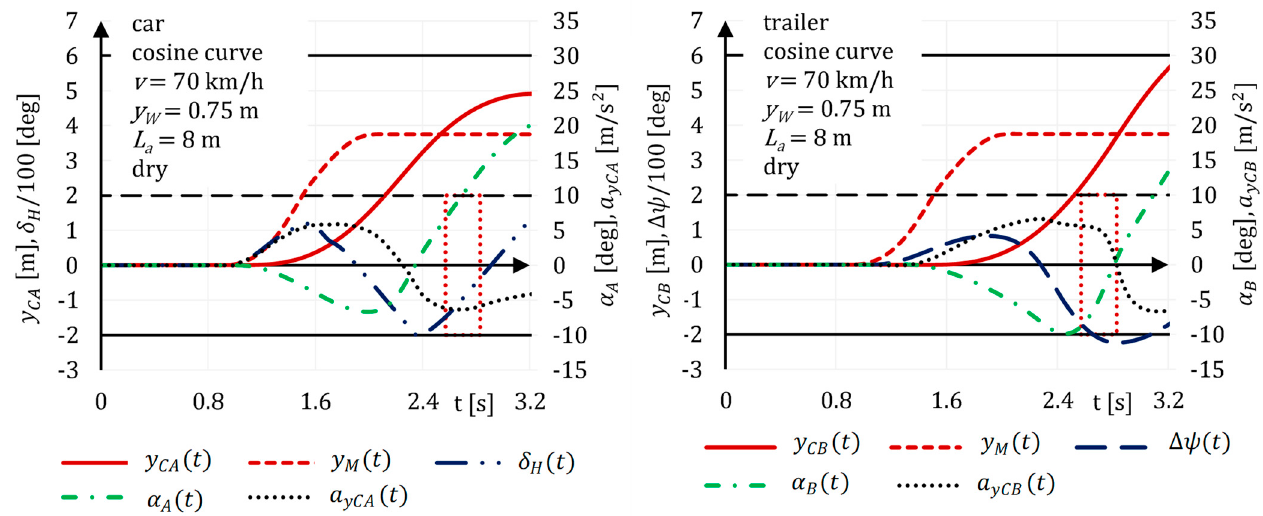
Figure 16. Curves analyzed in the procedure presented above (example obtained for the alternative with v = 70 km/h, dry road surface, and cosine method used to plan the trajectory).